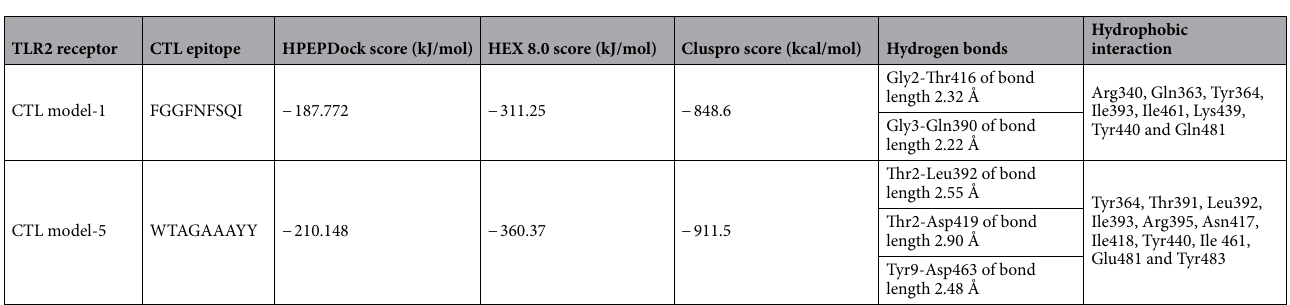
Table 4. Molecular binding analyses of shortlisted lead CTL epitopes with human TLR2 receptor with different docking